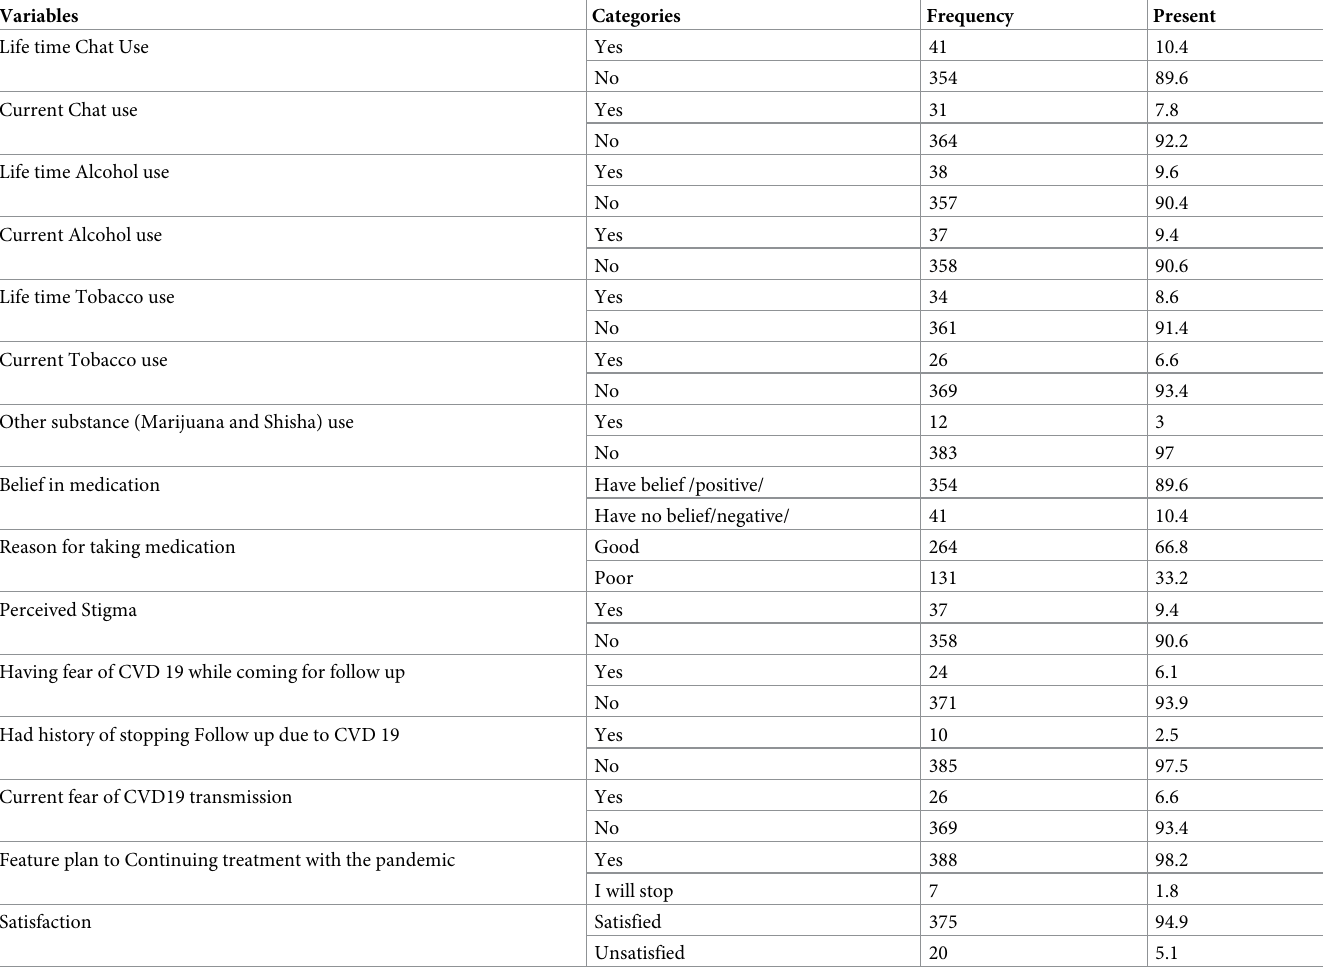
Table 2. Frequency distribution of respondents by patient related factors in Asela Referral and Teaching Hospital